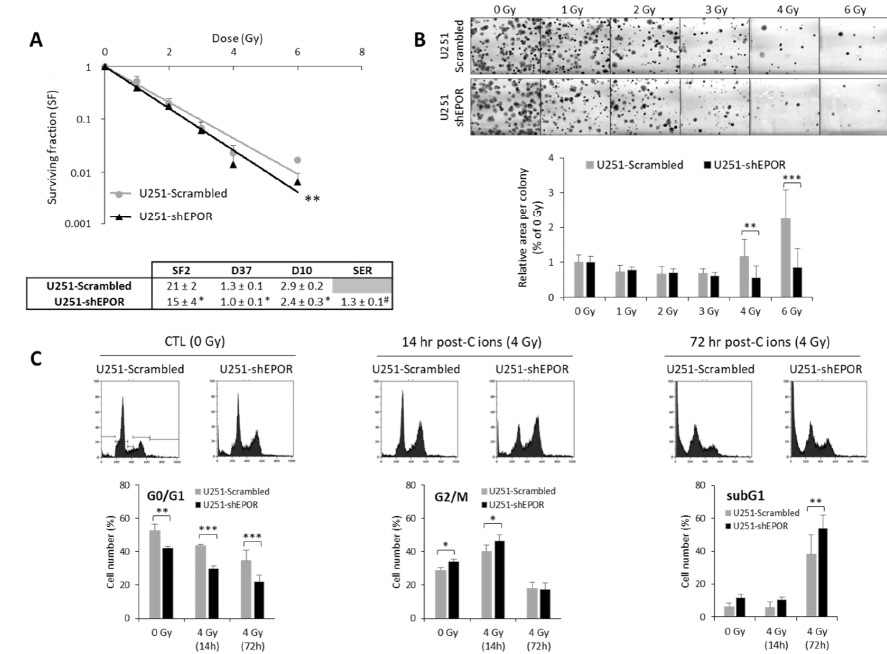
Figure 6. Effect of erythropoietin receptor (EPOR) downregulation on the sensitivity of U251 glioblastoma cells to carbon ion radiotherapy. ( A ) Survival curves of U251-scrambled and U251-shEPOR cells irradiated with carbon ion beams (C ions 50 KeV / µ m) under normoxia with doses ranging from 0 to 6 Gy. From clonogenic assays, the radiobiological parameters (SF2, D37, D10) and the sensitization enhancement ratio (D37 scrambled cells / D37 shEPOR cells) were quantified. Mean ± SD, N = 4 di ff erent experiments performed in triplicate ( n = 3) for both cell lines. For the survival curves: Fisher’s LSD post-hoc test after a significant two-way ANOVA (group and dose e ff ects) with ** p < 0.01 vs. U251-scrambled. For the radiobiological parameters: Student’s t -test with * p < 0.05 vs. U251-scrambled. For SER (sensitization enhancement ratio = D37 scrambled cells / D37 shEPOR cells): # p < 0.05 vs. theoretical value = 1 (univariate t -test); ( B ) Representative photographs of U251-scrambled and U251-shEPOR colonies obtained 10 days after carbon ion irradiation at increasing doses (21% O 2 , C ions 50 KeV / µ m). Measurement of area per colony for each irradiation dose for U251 cells genetically modified or not. Mean ± SD, N = 4 di ff erent experiments performed in triplicate ( n = 3) for both cell lines and irradiation conditions. Fisher’s LSD post-hoc test after a significant one-way ANOVA: ** p < 0.01 and *** p < 0.0001 vs. U251-scrambled. ( C ) Cell cycle profiles of U251-scrambled and U251-shEPOR cells exposed in normoxia to carbon ions (4 Gy, C ions 50 KeV / µ m) obtained at di ff erent times after irradiation (0, 14, and 24 h) (C-Top). Quantification of the cell distribution in di ff erent phases of cell cycle as a function of time (C-Bottom). Mean ± SD, N = 3 di ff erent experiments for both cell